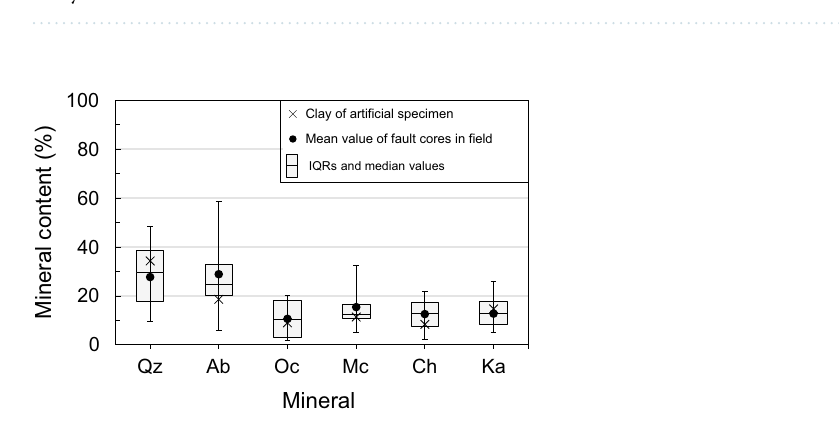
Mineral Quartz Albite Kaolinite Microcline Orthoclase Chlorite Rest Content (vol.%) Table 1. Mineral contents of the clay used for manufacturing artificial specimens, as determined by XRD analysis.